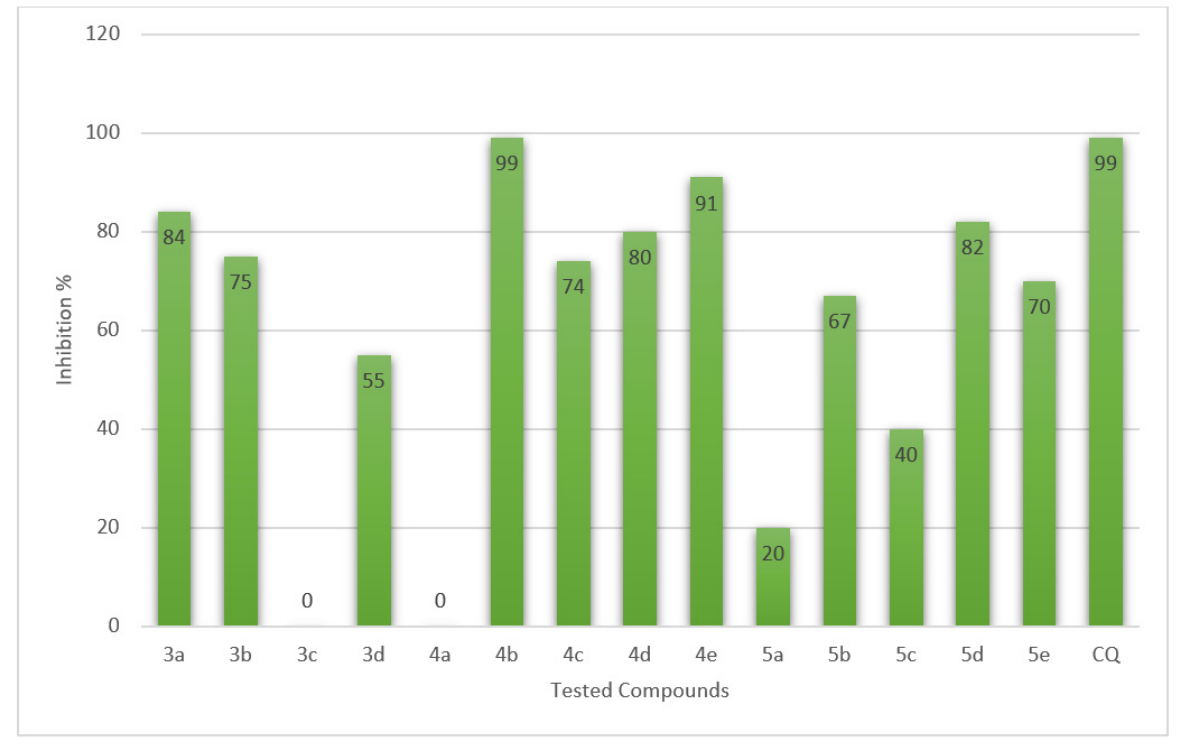
Figure 5. Inhibition % of the compounds 3a – c , 4a – e , 5a – e , and Chloroquine as a reference drug.